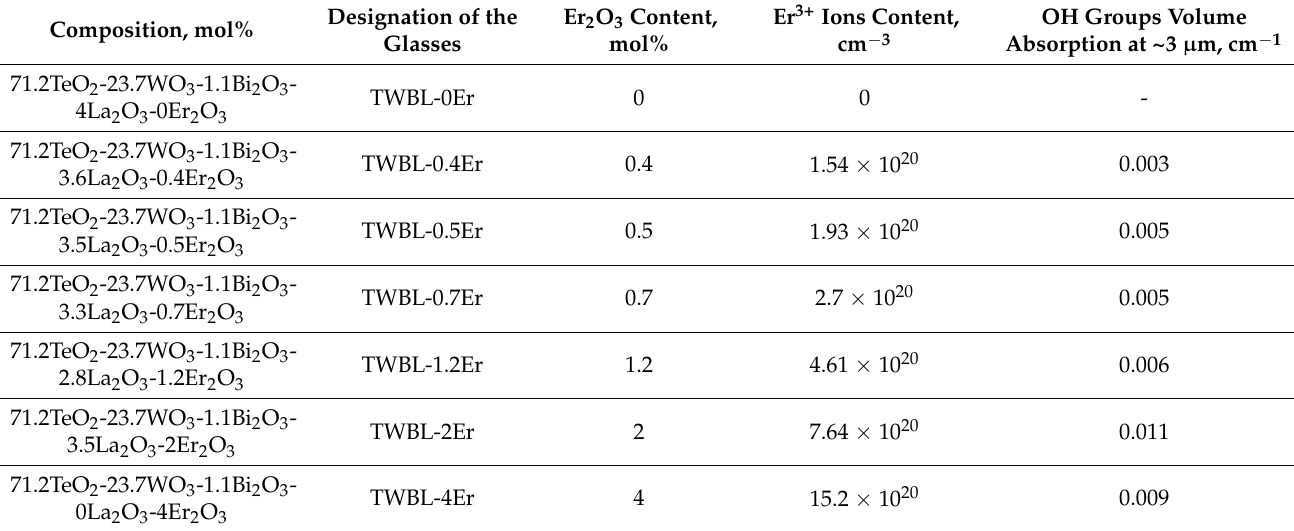
Table 1. The compositions of glasses of the studied TWBL-xEr series, designations, the content of the erbium oxide dopant, and hydroxyl group absorption at ~3 µ